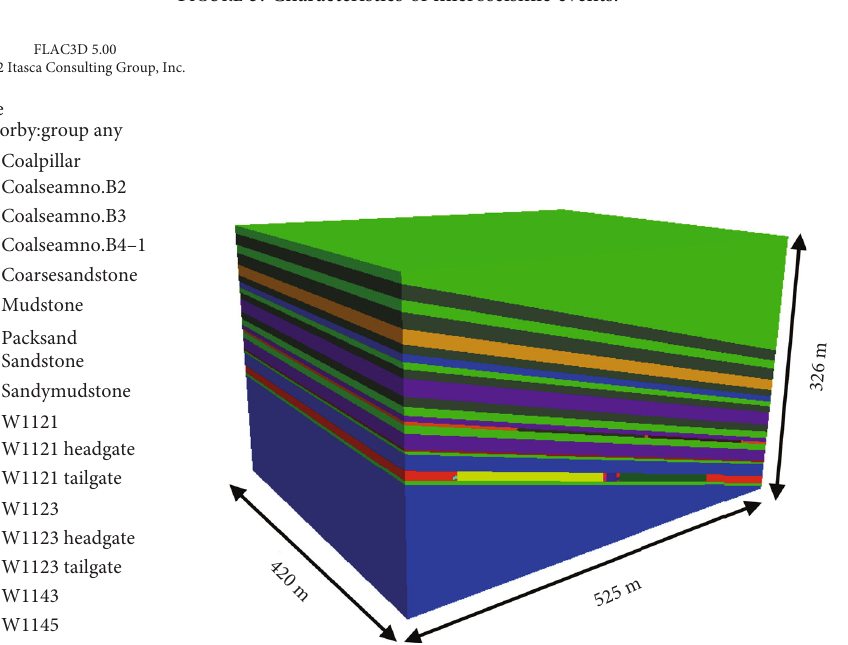
Figure 3: Characteristics of microseismic events.